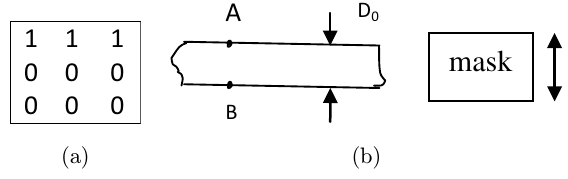
Fig. 9. Masking and shifting process; (a) Mask operator (b) Shifting of mask.